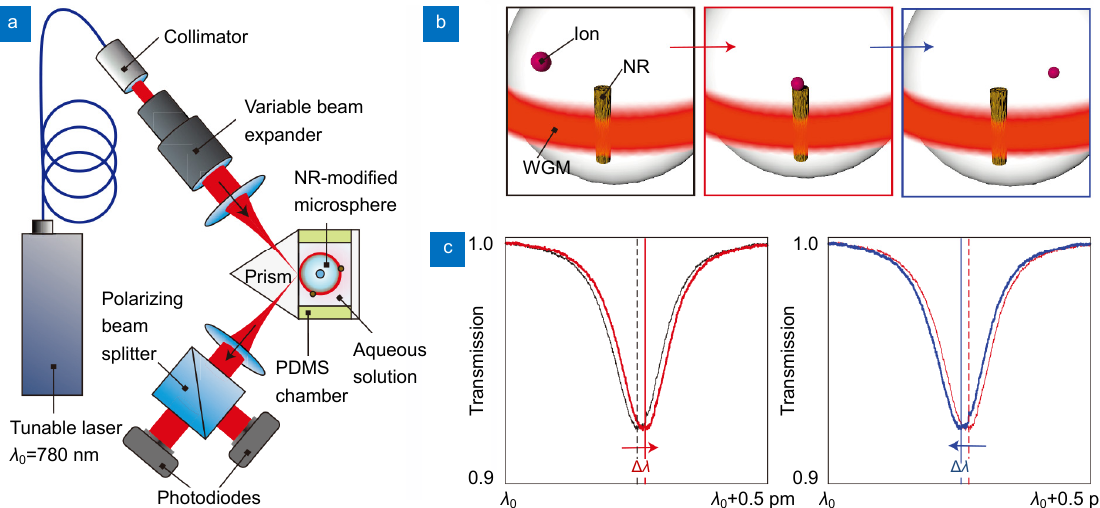
Fig. 3 | ( a ) Layout of the WGM sensing set-up. ( b ), ( c ) Transient interactions of single zinc or mercury ions with the NRs with the corresponding spectrum shifts. Figure reproduced from ref. 5 , Springer Nature.